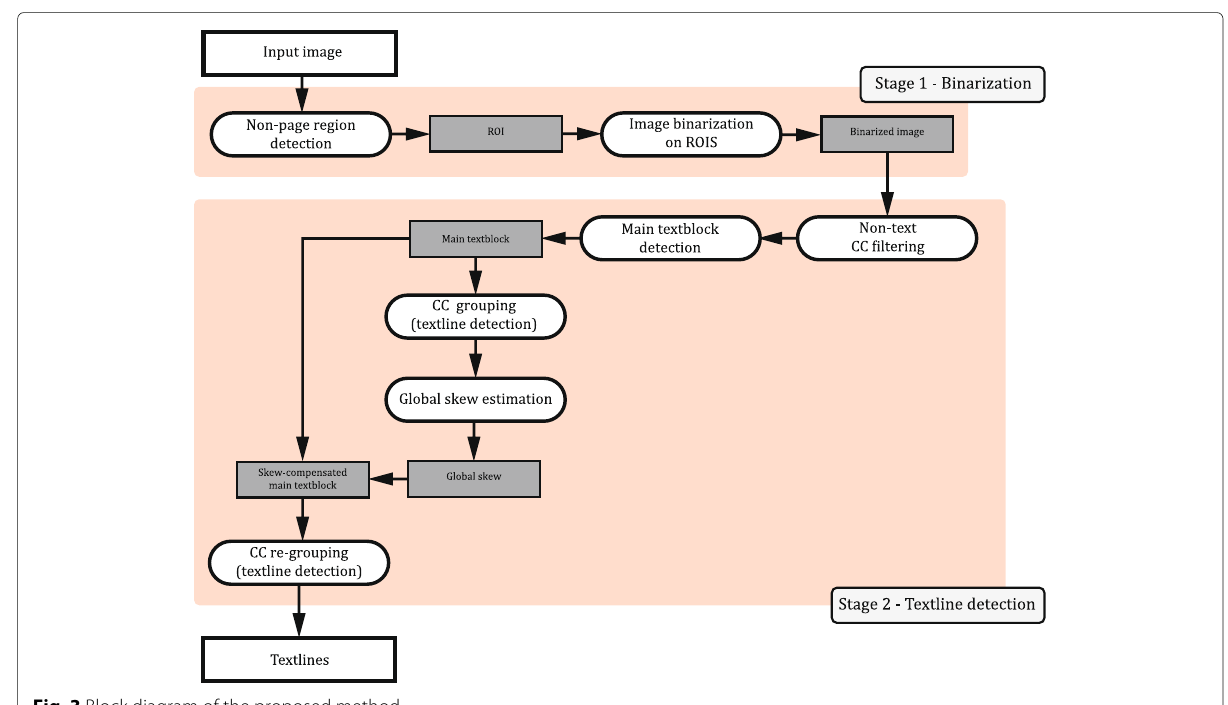
Fig. 3 Block diagram of the proposed